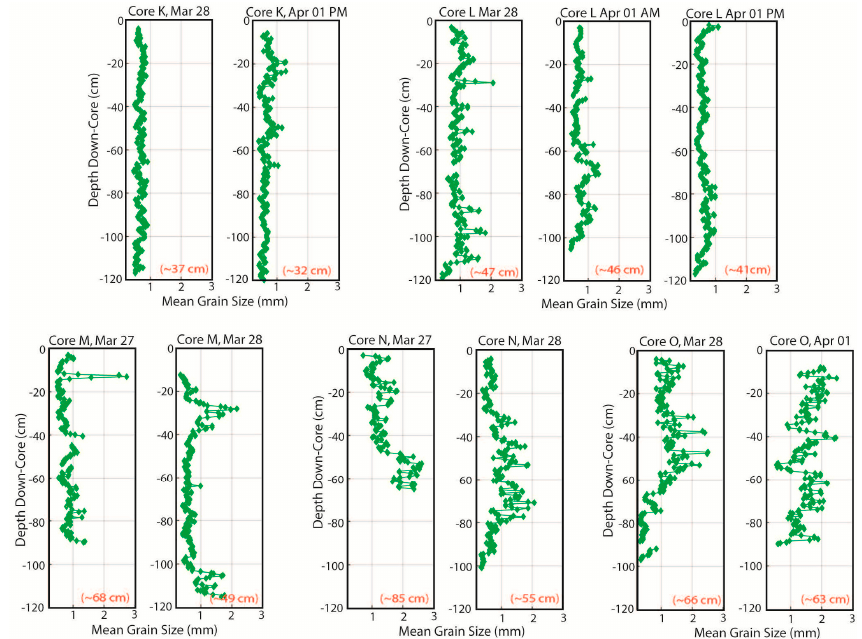
Figure 3. Examples of grain size data measured with the DIS, as preserved in sediment cores, at different locations during the experiment. Red numbers indicate measured compaction. See text for full explanation and discussion.